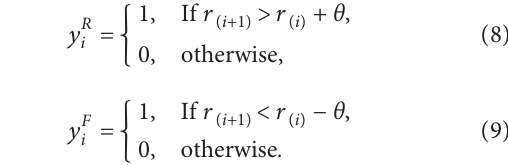
Table 2: Selected technical indicators.